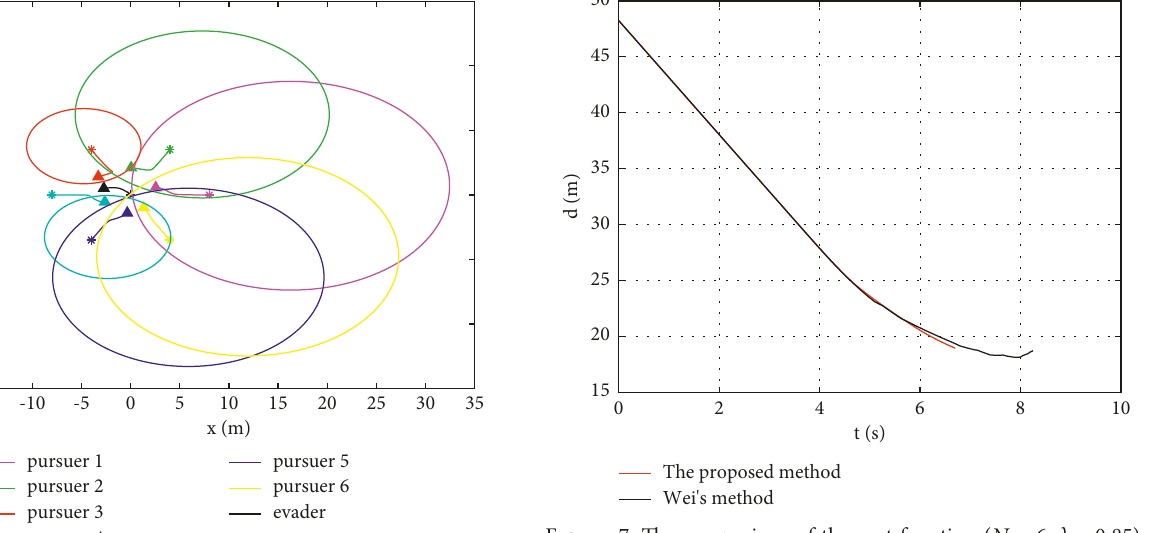
Figure 7: The comparison of the cost function ( N � 6, λ � 0 . 85). Table 1: The required number N of pursuers with given λ .